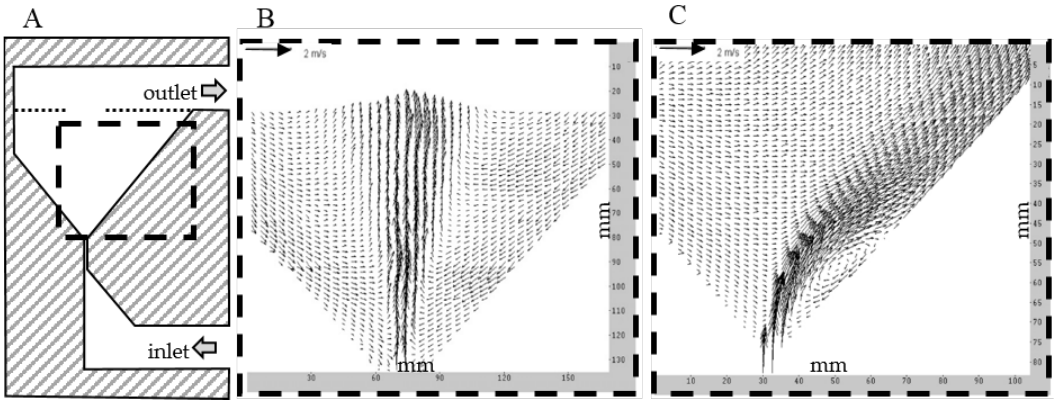
Figure 3. ( A ) the vertical cross-section of the scaled model with the symmetrical outlet in dotted lines adapted from [87]; ( B ) the average velocity field of the jet using a symmetric outlet (dotted line in ( A )); and ( C ) the average velocity field of the wall-attached jet using the asymmetric outlet. Reproduced with the permission from [87]; Lund Inst. of Technology, 2005.